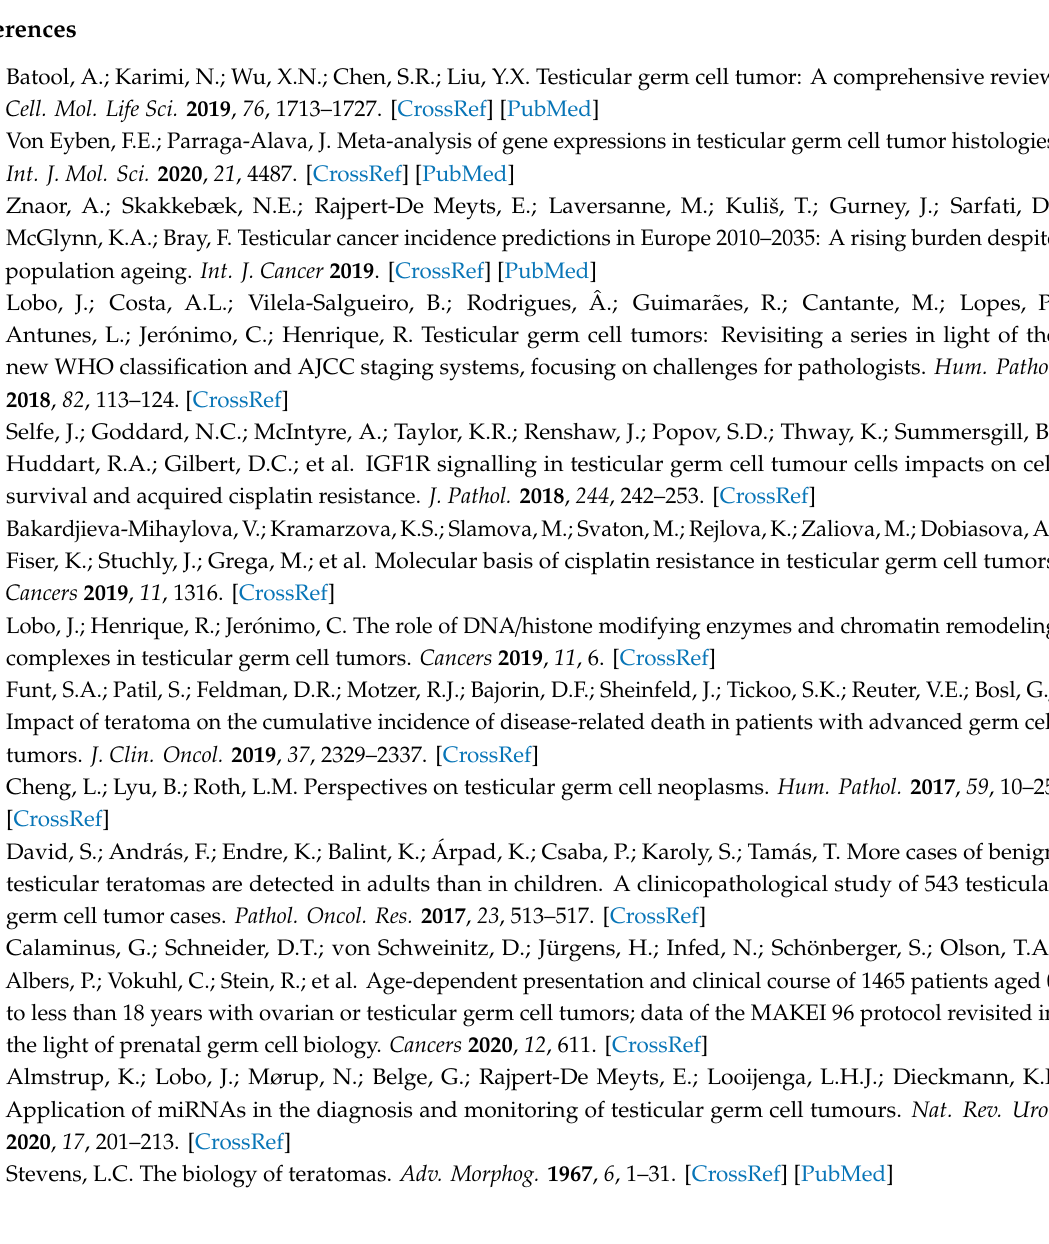
Table S1: Antibodies used in IHC, Table S2: Antibodies used in Western blot, Table S3: Primer sequences used in qPCR, Figure S1: Western blots with densitometry